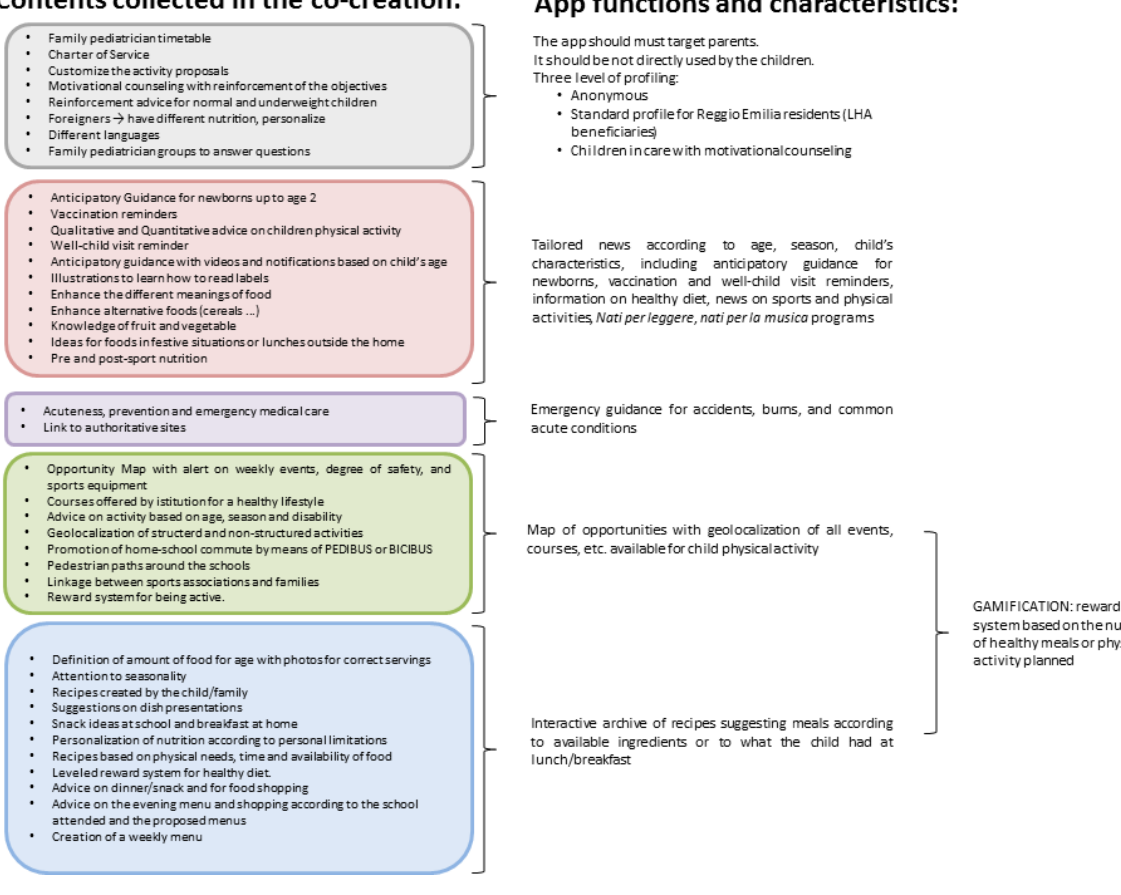
Figure 5. Translating needs into app